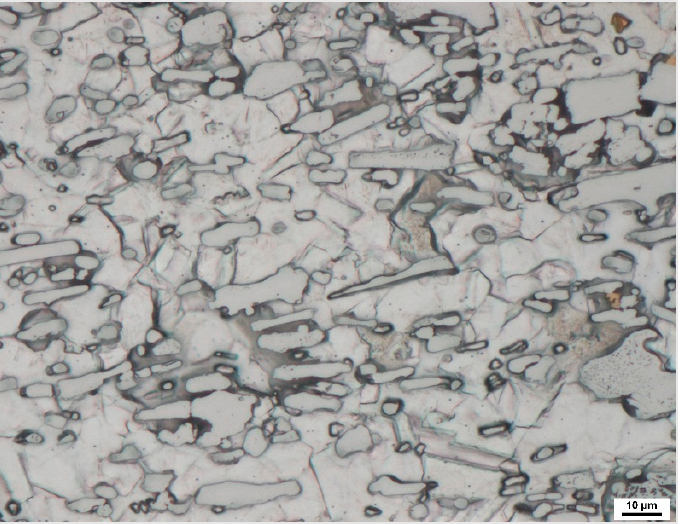
Figure 2. Microstructure of the input material (after solution treatment) revealed in Hamil etchant. ASTM grain size G 10.2. The microstructure is fully recrystallized, polyhedral, and shows uniformly distributed borides with exclusive orientation in the rolling direction.